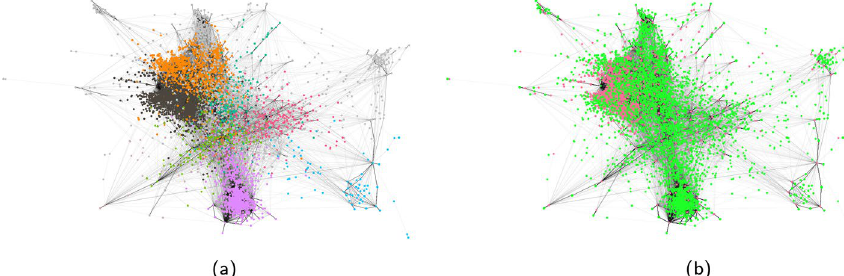
Fig. 4 Largest component of the Honduras projected retweet user-message bipartite interaction network a Community membership. b Type of user (red: flagged, green: normal)